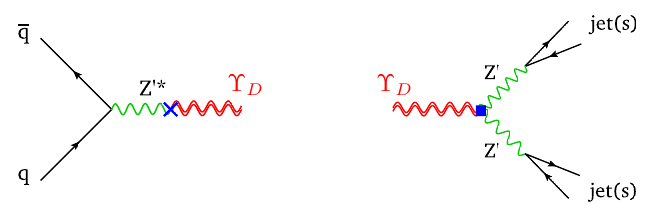
Figure 3 . Left : Feynman diagram for darkounium state (cid:7) D production at LHC. The blue cross represents the (cid:7) D - Z 0 kinetic mixing given in eq. (2.10). Right : Feynman diagram for one of the (cid:7) D decay channels, into two Z 0 bosons, with the latter cascade decay into jet(s). The blue square represents the (cid:7) D - Z 0 - Z 0 vertex given in eq.